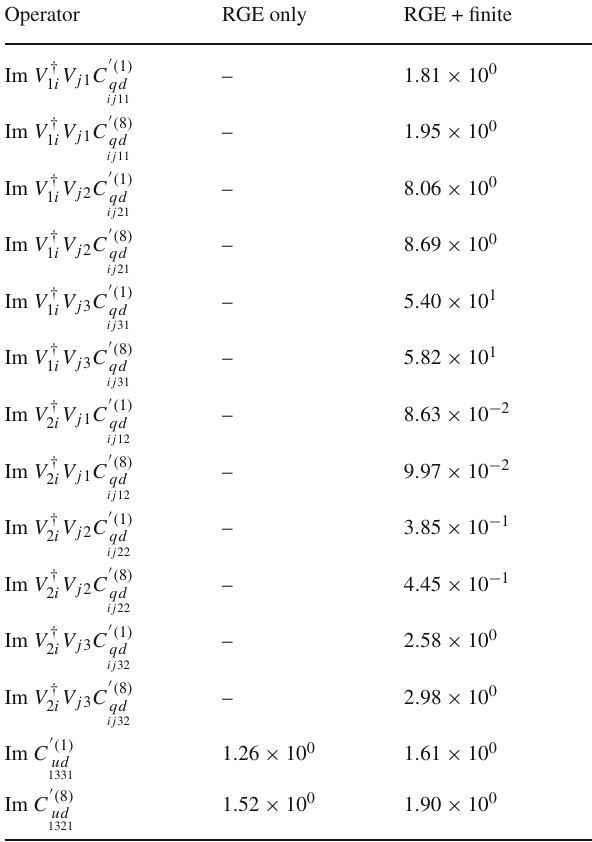
) . u , d , e ( 1 , 8 ) , O ( 1 , 8 ) , O ( 1 , 8 ) qu qd ud